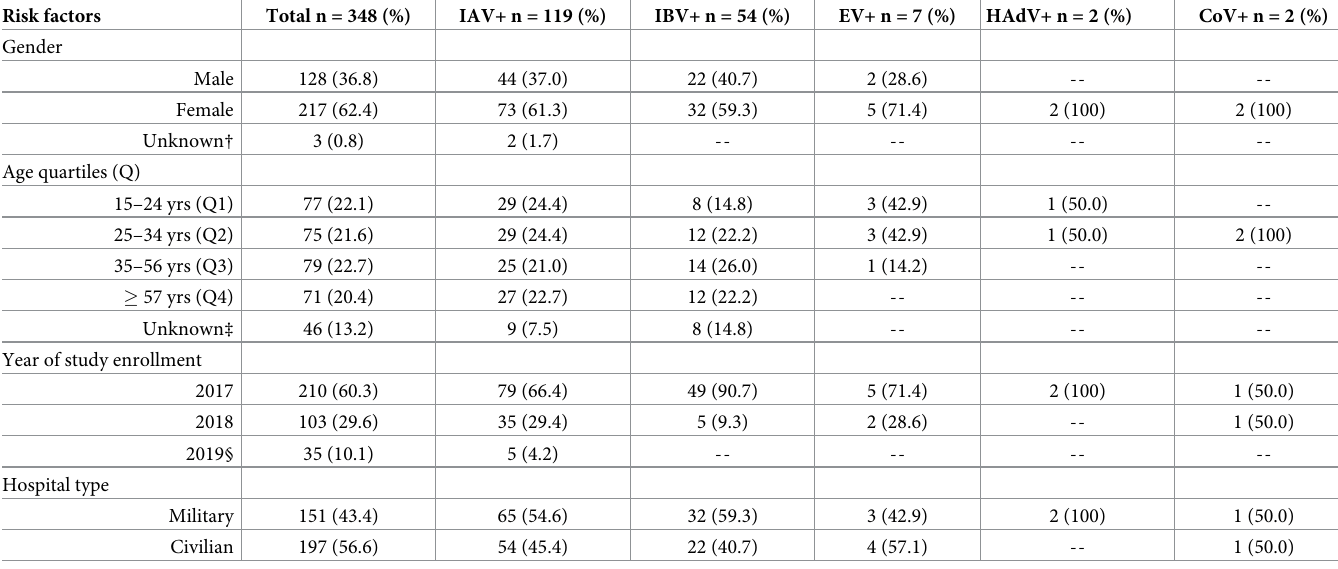
Table 2. Viral detections � among 348 patients with severe acute respiratory illness in the Hanoi area,